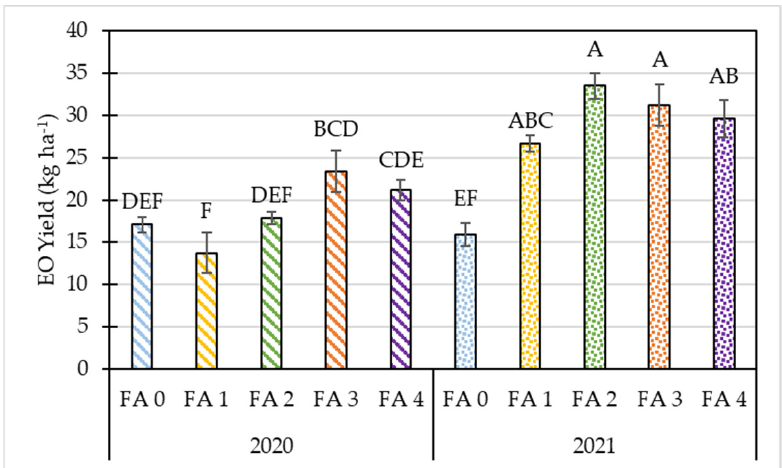
Figure 7. Influence of interaction Y × FA on Essential Oil (EO) Yield. FA0: only water; FA1: 8 g L − 1 of CaO; FA2: 12 g L − 1 of CaO; FA3: 8 g L − 1 of CaO + 16 g L − 1 of urea; FA4: 12 g L − 1 of CaO + 16 g L − 1 of urea. Values with diverse letters are significantly different at p ≤ 0.05 according to Tukey’s test. Bars represent the standard deviation.